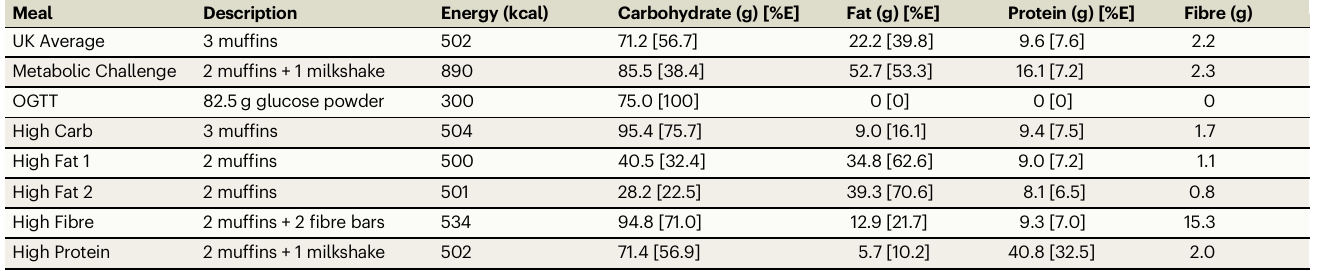
Table 1 | Nutritional composition of the standardised breakfast meals Meal